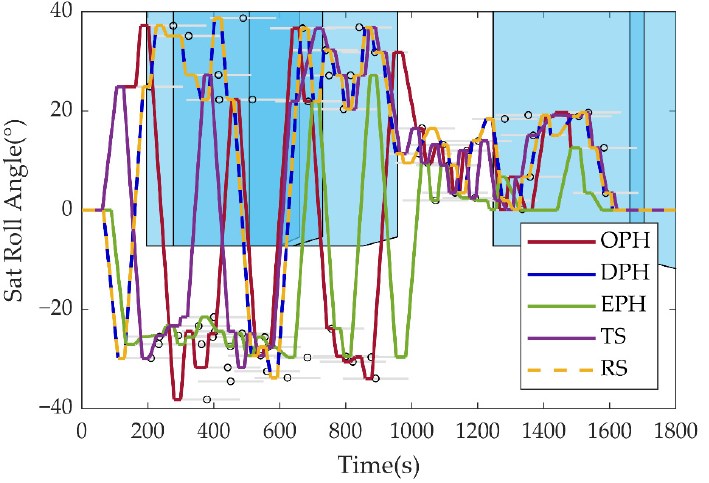
Figure 11. Targets selection and observation path diagram of a single condition in the second group.